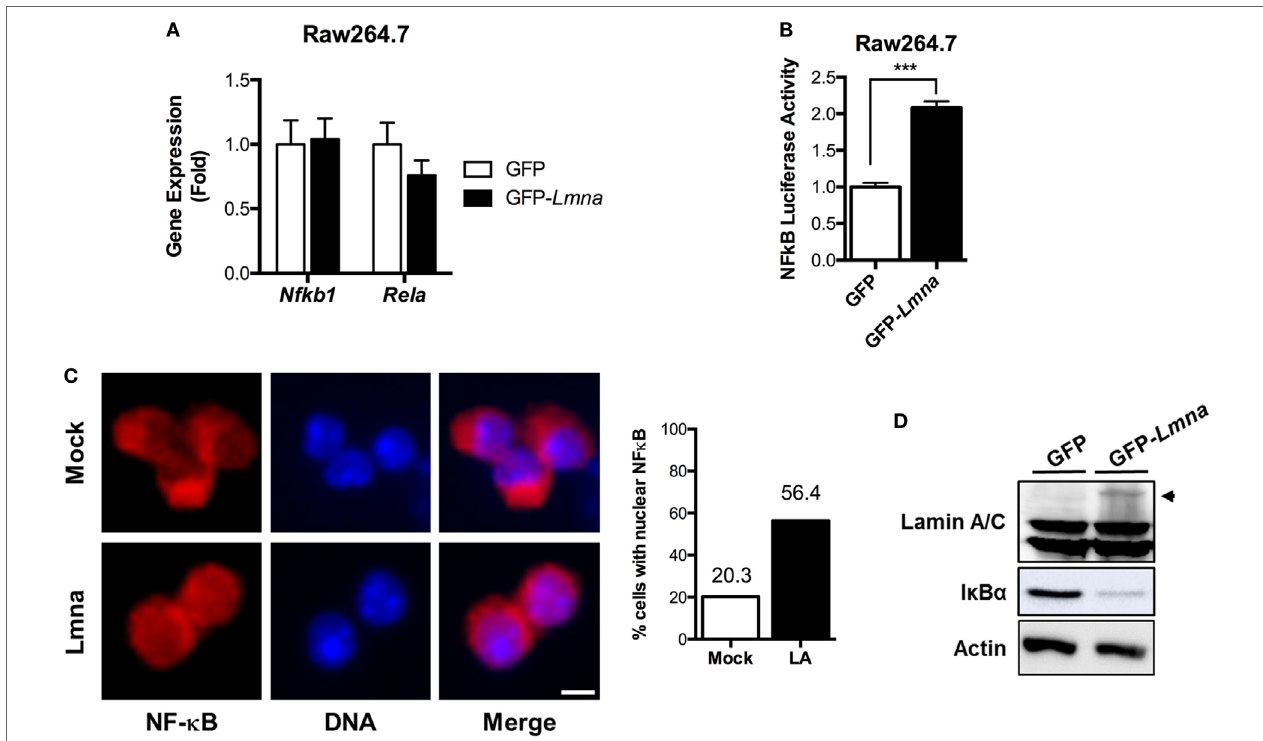
FigUre 4 | Lamin A/C increases NF- κ B activity via nuclear translocation of p65/Rel A, a NF- κ B complex subunit. (a) qRT-PCR analysis of Nfkb1 and Rela in Raw 264.7 cells transfected with either GFP or GFP- Lmna . (B) NF- κ B luciferase activity in Raw 264.7 cells co-transfected with GFP or GFP- Lmna together with pNF- κ B-Luc, a luciferase reporter construct that has κ B responsible elements in the promoter. Luciferase activities were normalized by those in cells co-transfected with a non-reporter plasmid, pRL-SV40. (c) Immunofluorescence images of bone marrow-derived macrophages transfected with GFP (Mock) or GFP- Lmna (Lmna) and quantitation for cells with nuclear NF- κ B p65/Rel A. Cells with nuclear NF- κ B were defined based on the presence of nuclear signal and obvious lack of cytoplasmic signal as shown in the representative images (Scale bar: 5 μ m). (D) Immunoblots of lysates from transfected Raw 264.7 cells with anti-Lamin A/C (top), anti-I κ B α (middle), or anti-actin (bottom). Arrowhead marks GFP fusion lamin A protein